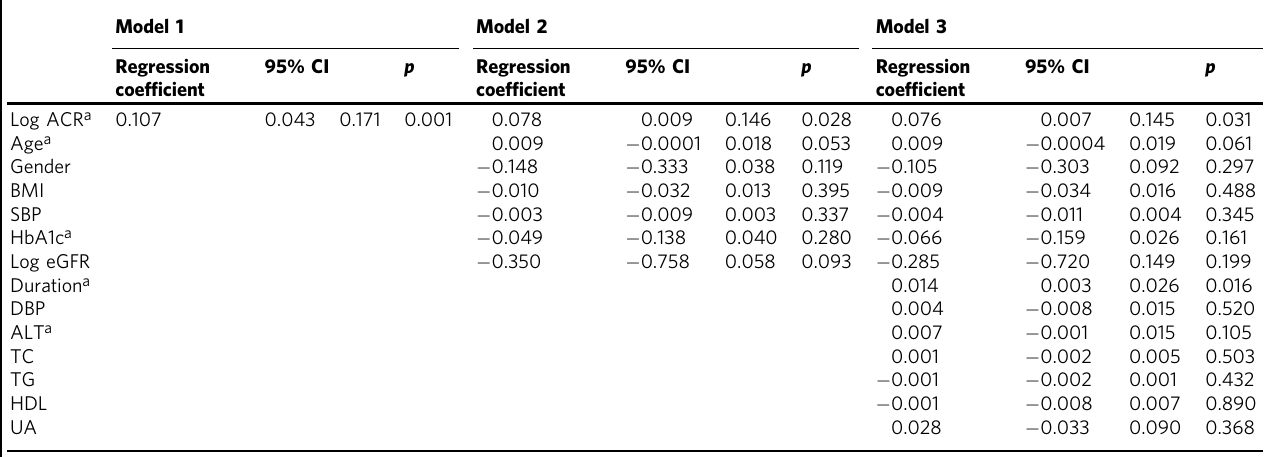
Table 2 Multiple regression analysis (objective value: (PS + 1)) Model 1